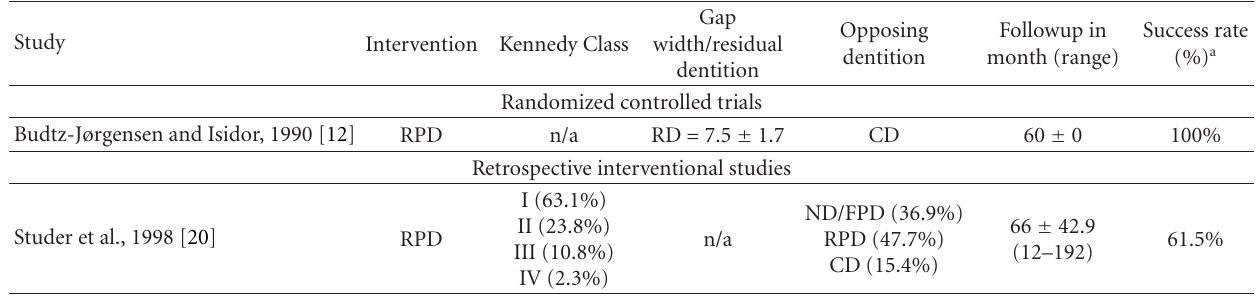
Table 5: Longevity of removable